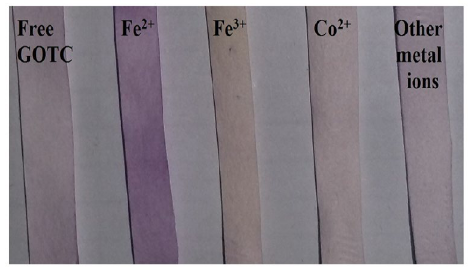
Fig. 6. Paper sensing of Fe 2+